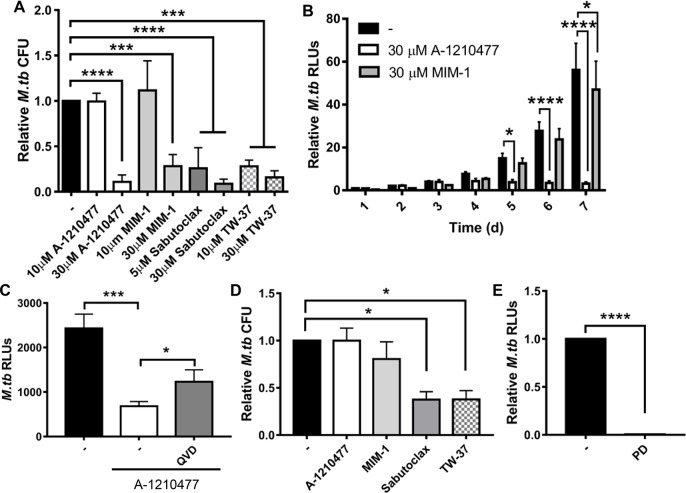
Mcl-1 inhibition limits M.tb growth.A) MDMs were infected with M.tb at MOI 1, then treated with the indicated Mcl-1 inhibitors. After 4 d, cells were lysed and CFU enumerated. B) MDMs were infected with M.tb-lux at MOI 1, then treated with the indicated Mcl-1 specific inhibitors. M.tb luciferase activity was measured over time. C) MDMs were infected with M.tb-lux at MOI 1, treated with 100 nM Q-VD-OPH (QVD) for 1 h, then 30 μm A-1210477 and M.tb luciferase activity was measured after 3 d. Results are the mean ± SD of a representative experiment of 2, in triplicate. D) Human PBMCs were infected with M.tb at MOI 1 to generate in vitro TB granulomas, and after 1 day, treated with the indicated Mcl-1 inhibitors (30 μM). After 6 d with inhibitor, cells were lysed and CFU enumerated. E) MDMs were infected with M.tb-lux at MOI 1, then treated with PD146176 (50 μm). After 4 d, M.tb luciferase activity was measured. A-E) Results are the mean ± SEM of N = 3 unless indicated otherwise, * p < 0.05, *** p < 0.001, **** p < 0.0001.